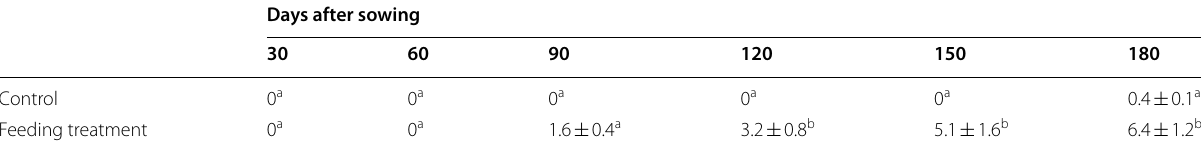
Data are mean SD. Means within a column followed by the same letter are not significantly different at P ±